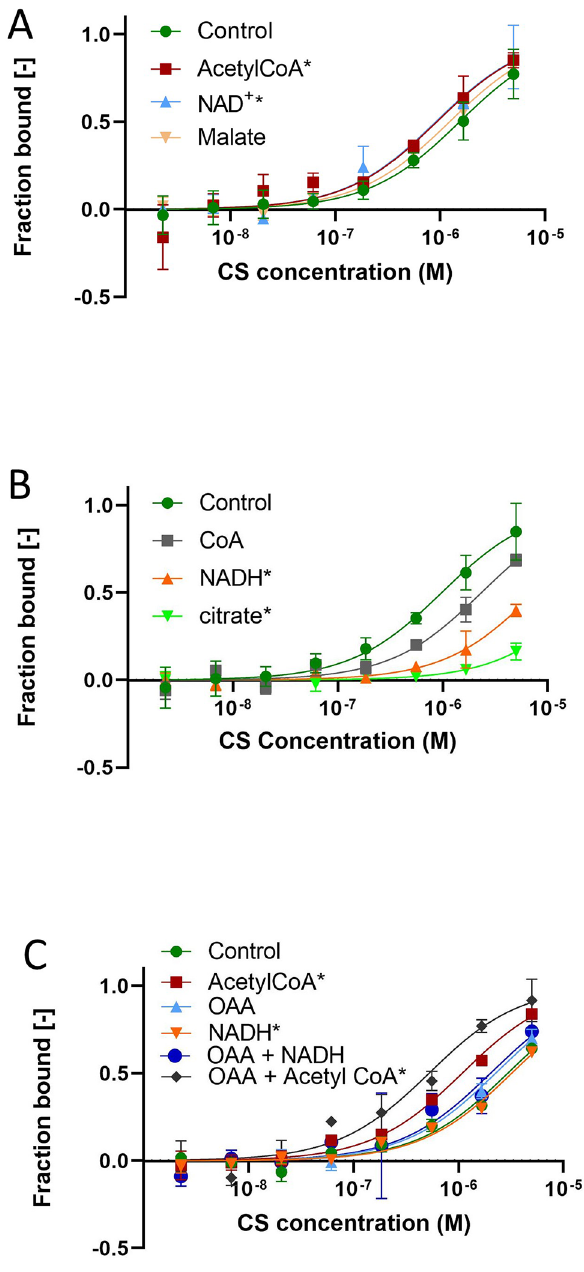
Figure 1. Effects of metabolites involved in the MDH and CS reactions on the affinity of the MDH-CS multi-enzyme complex. The affinity of the MDH-CS multi-enzyme complex was analyzed by microscale thermophoresis (MST) using fluorescently labeled MDH and CS as the ligand. Curves represent the response (fraction bound) against CS concentration (M). The interaction was assessed in the MST buffer (control, green) or those with 10 mM of metabolites. Error bars represent the standard deviations of three measurements. Asterisks indicate the conditions that showed significant K d differences with no K d confidence overlap with the control. ( A ) Effects of reaction substrates of MDH and CS. The MDH-CS interaction was assessed in the presence of acetyl-CoA (red), NAD + (blue), or malate (brown). ( B ) Effects of reaction products of CS and MDH. The MDH-CS interaction was assessed in the presence of CoA (grey), NADH (orange), or citrate (green). ( C ) Effects of the oxalacetate (OAA) in combination with other CS substrates. The effects of sole substrates, acetyl- CoA (red), OAA (blue), and NADH (orange), as well as their combinations, OAA/acetyl-CoA (purple) and OAA/NADH (gray), were